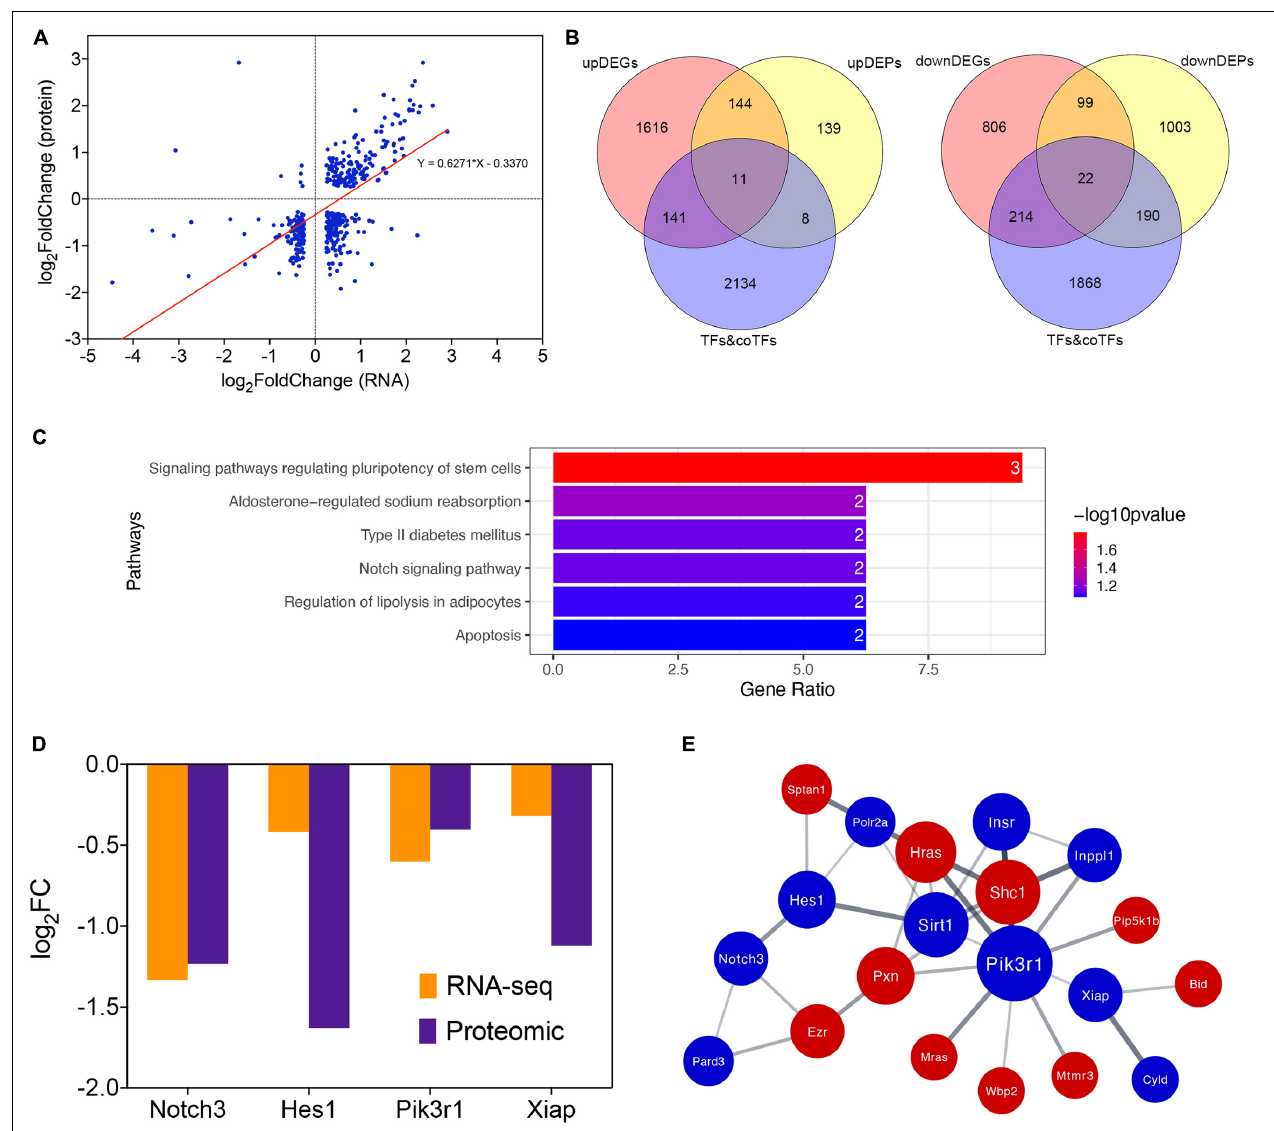
FIGURE 4 | Integrated analysis of transcriptomic and proteomic changes in cold treated lens capsules of the Hypothermia Group. (A) Correlationship between transcriptomic and proteomic results, the horizontal coordinate indicates the log2FoldChange of DEGs, while the vertical coordinate indicatesthe log2FoldChange of DEPs. (B) Overlap of differentially expressed genes (DEGs, differentially expressed proteins (DEPs, and translation factors (TFs) and cofactors (co-TFs) database, up-regulated and down-regulated part were separated. (C) KEGG pathway enrichment analysis of differentially expressed TFs&co-TFs. (D) RNA and protein expression level of the four TFs&co-TFs in the Notch signaling pathway and Apoptosis KEGG pathways. (E) PPI network of Notch3, Hes1, Pik3r1, and Xiap and their first neighbors in the PPI network of DEGs and DEPs regulated in the same